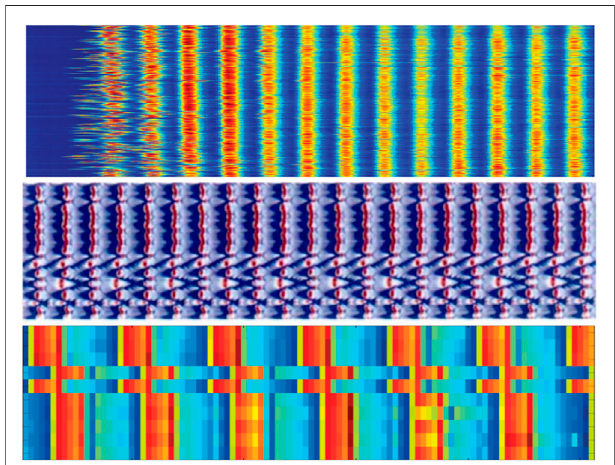
FIGURE 9 | Synchronization induced by imperfections. Three examples of arrays of nonlinear systems in which organized behavior arises thanks to diversity and imperfections in the model. From top to down: coherent oscillations in the dimension of populations of E. Coli , organized collective motion of forced pendulums, and synchronized behavior of imperfect rotating coils.